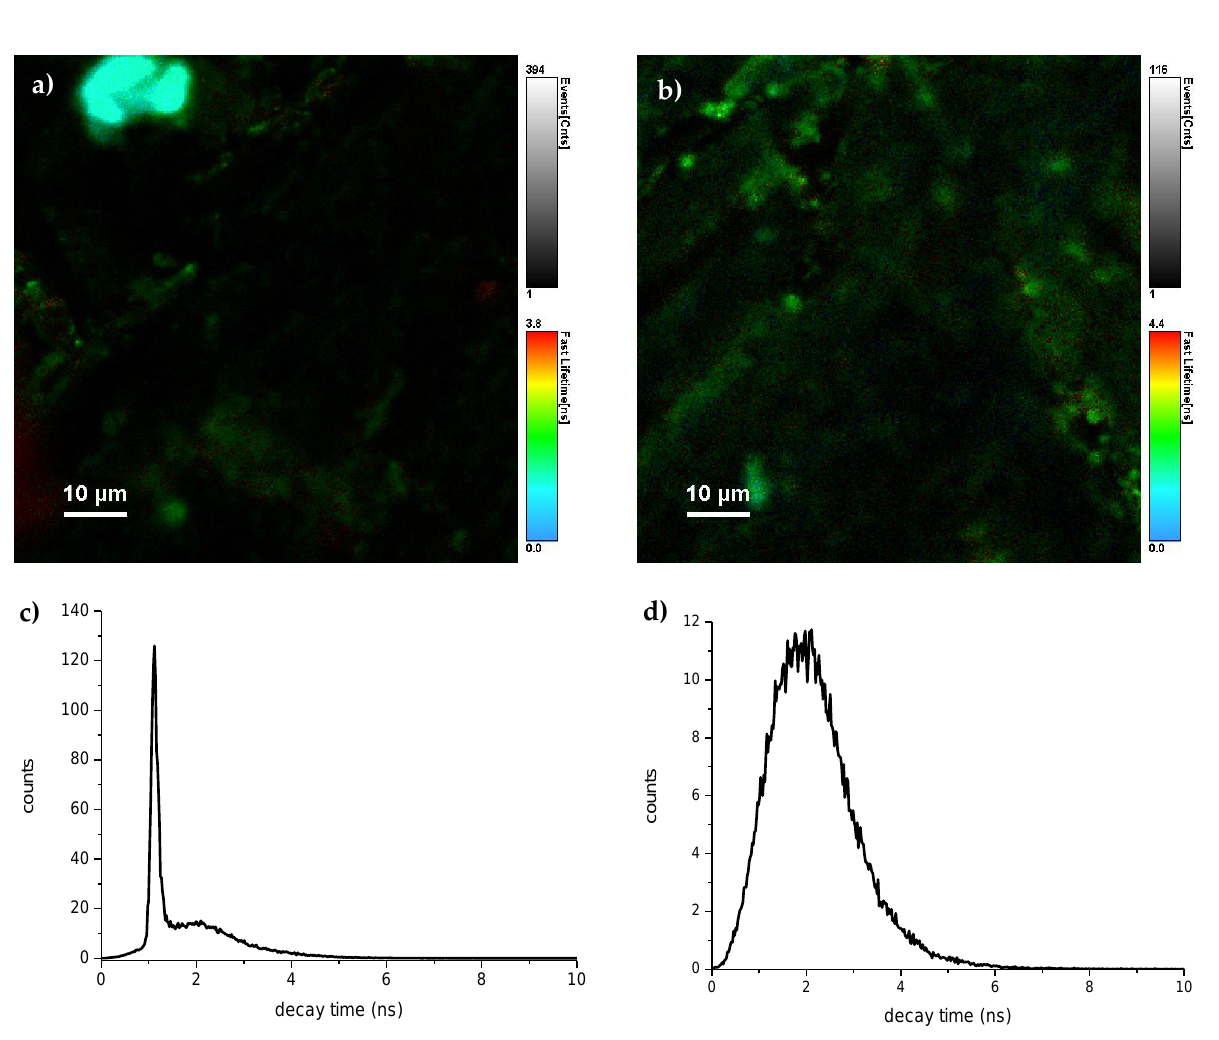
Figure 7. Emission intensity of selected YAM: 0.5% Ce 3+ + 1% Yb 3+ sample, in two distinct areas (a, b). Colors correspond to the luminescence decay times scale. Uniformity of the luminescence decay times is illustrated with histograms of the decay times recorded in the areas pictured above them (c, d).